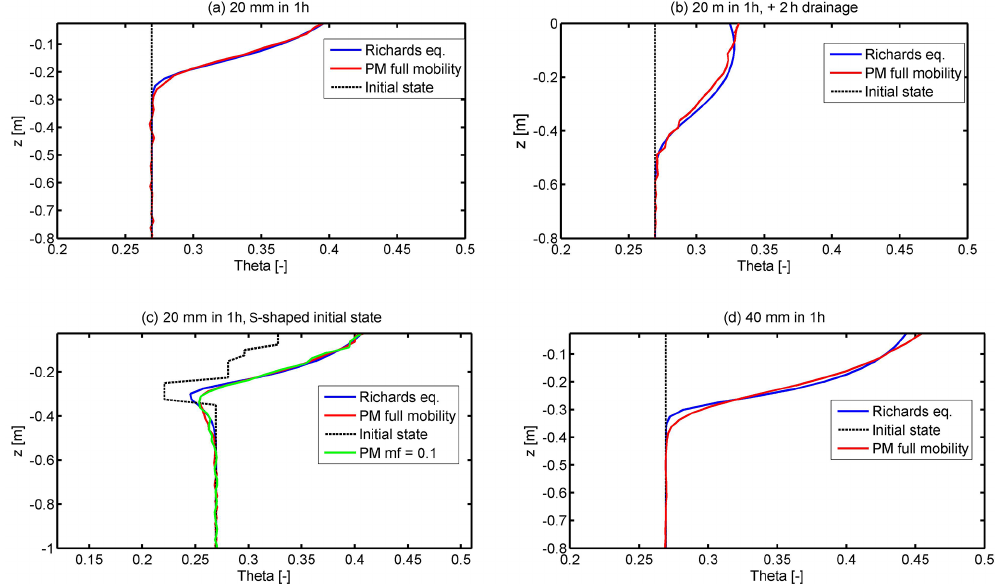
Figure 5. Final soil moisture profiles simulated with the Richards equation and the particle model for the young silty soil on schist. Panel (a) and (b) show the final states after a block rain of 20mm and an additional 2h of drainage, respectively. Panel (c) compares simulations starting from the S-shaped initial soil profile with the full class approach and a mobile fraction, mf, of 10%. Panel (c) compares the full class approach against the Richards equation starting for a 40mm block rain of 1h. The dashed grey line marks the initial soil moisture profiles.